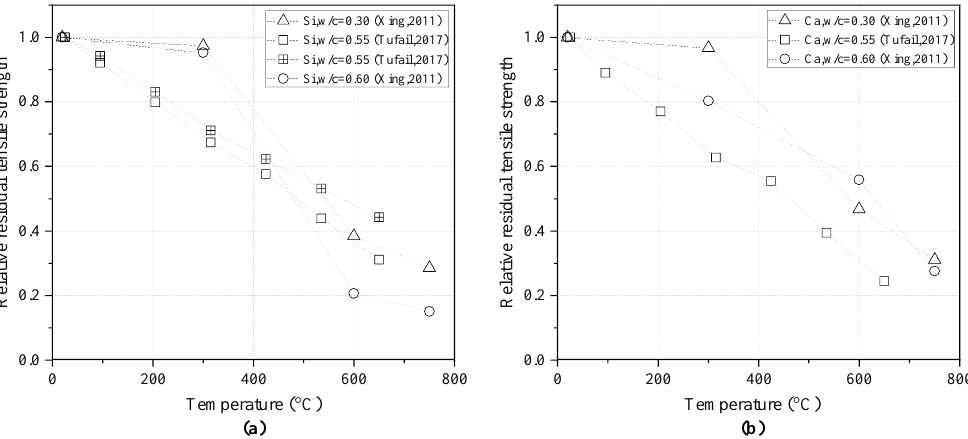
Figure 13. The relative residual tensile strength of concrete: ( a ) siliceous (Si)-aggregate concrete, ( b ) calcareous (Ca)-aggregate concrete [72,74].